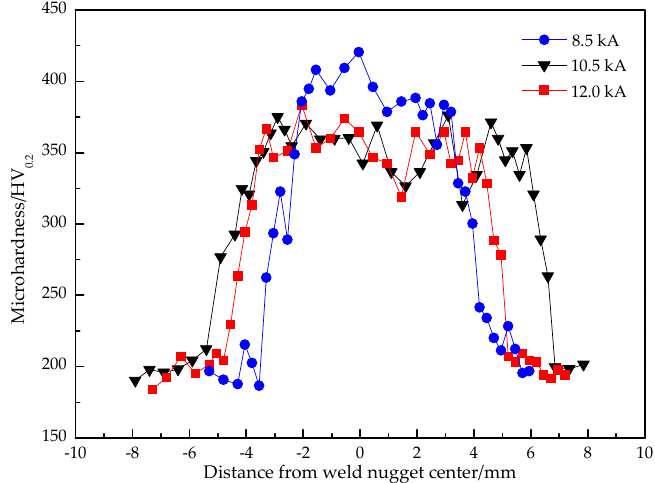
Figure 12. Microhardness distributions of welded joints with different welding currents.